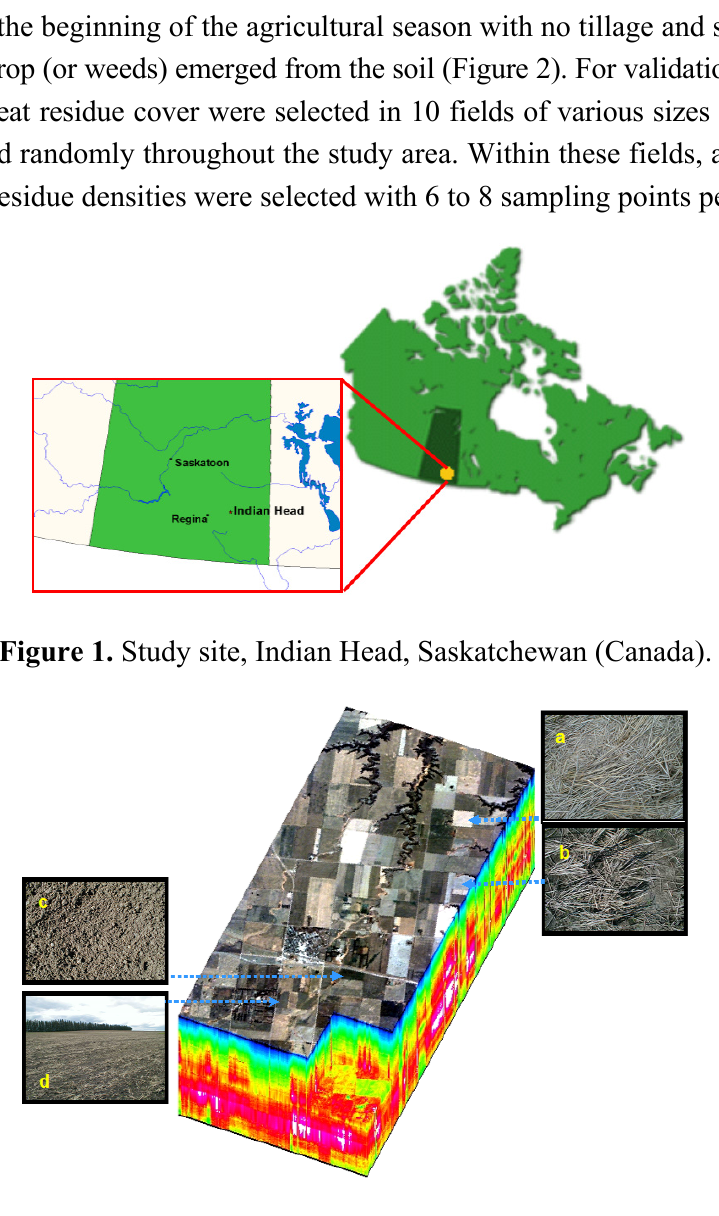
Figure 2. True-color composite of the Hyperion 3D cube sub-scene (7.50 km by 16.08 km) and acquired photographs of residue ( a , b ), soil status ( c ), and mixed soil and residue ( d ) for validation